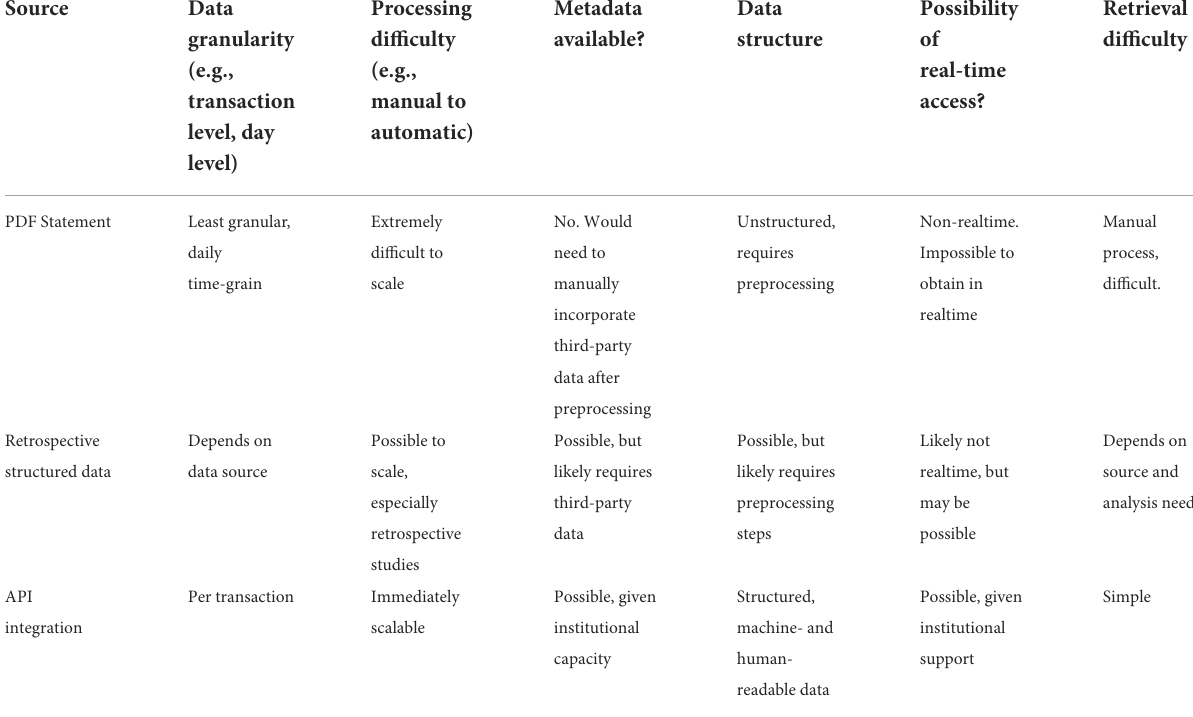
TABLE 4 Factors to consider when collecting objective financial